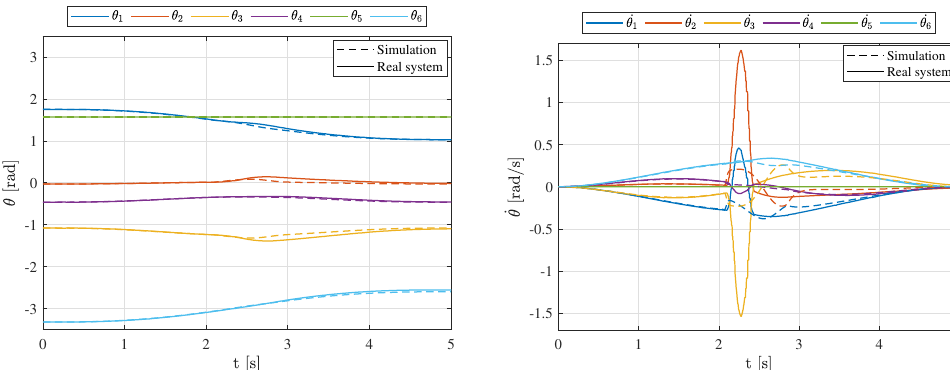
Figure 9. Test case 2, Mode II. Joint rotations ( left ) and speeds ( right ).